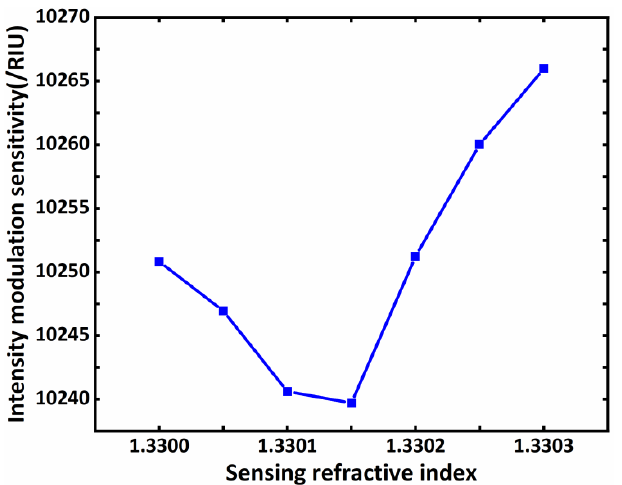
Figure 6. The resonance angle and sensitivity vary with the refractive index of the sensing medium layer. The other parameters have the same values as those in Figure 2.